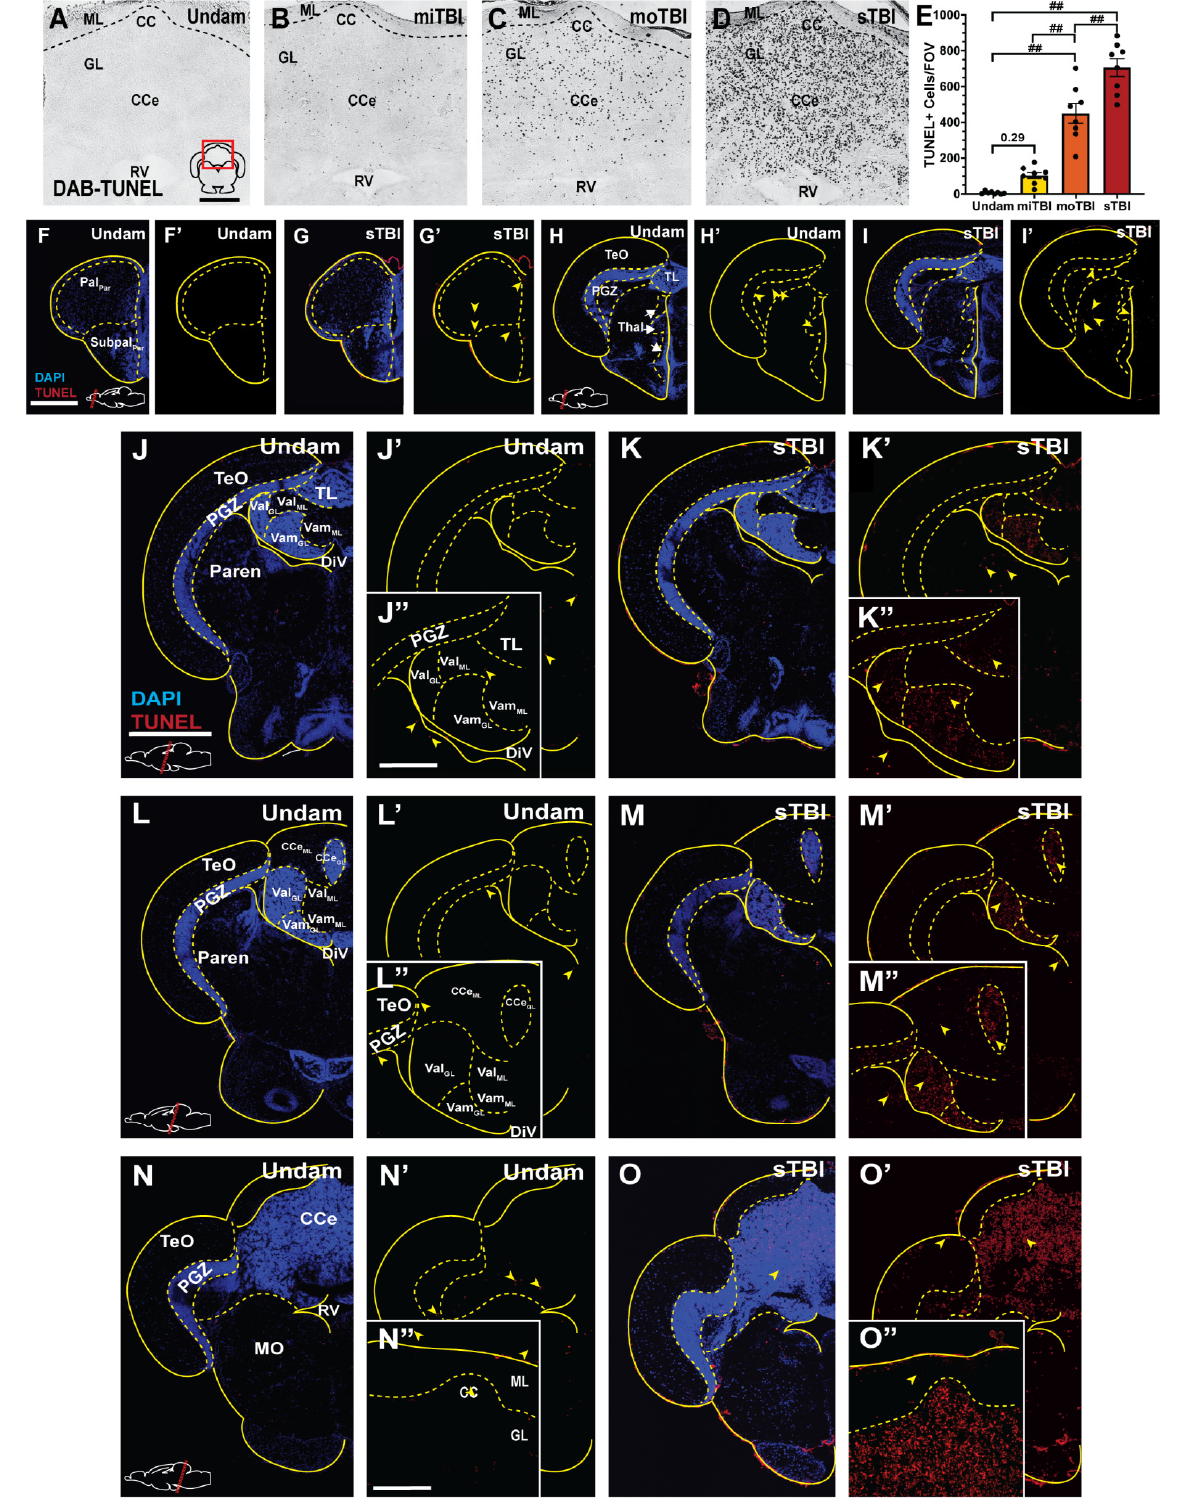
Figure 4. Cell death is severity-dependent and radiates out from the impact zone as a gradient. ( A – D ) Brightfield images of coronal cerebellar (CCe) sections stained with DAB-TUNEL 16 hpi. Prominent DAB TUNEL-positive cells were observed